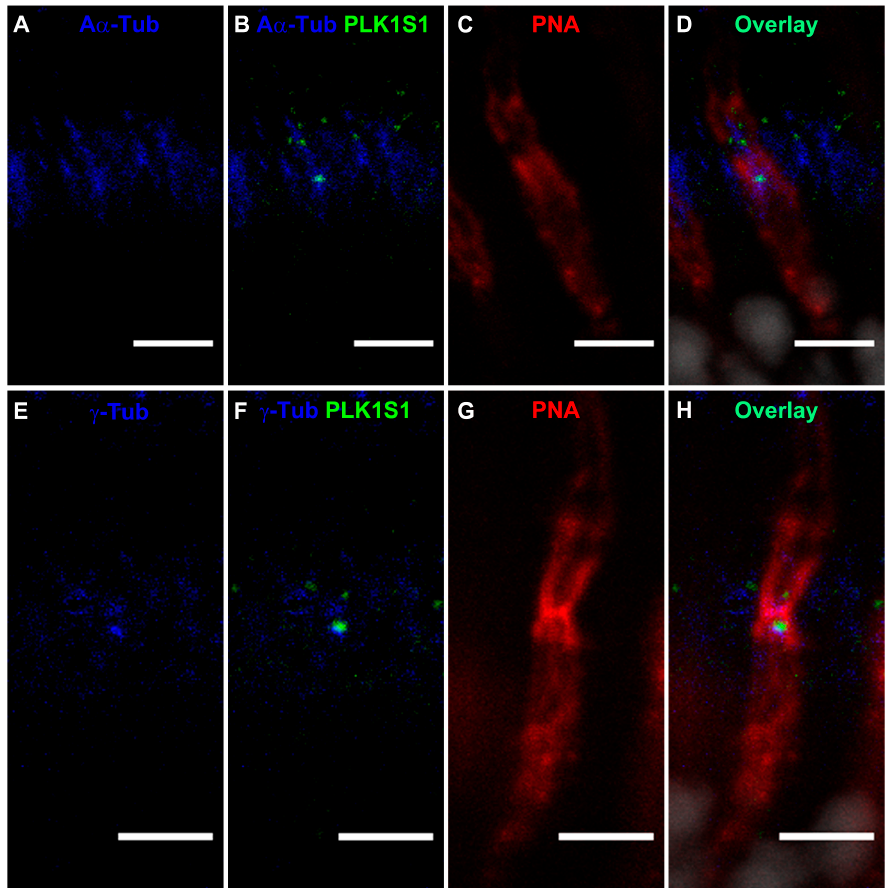
Figure 8. Immunolocalization of PLK1S1 in adult mouse retina revealed PLK1S1 localization in the BB of cone photoreceptors. ( A – H ) Close ‐ up of cilia (acetylated α‐ tubulin (A α‐ Tub) or γ‐ tubulin ( γ‐ Tub), blue) of the cone photoreceptor (PNA, red). Merged images show that PLK1S1 is localized in close vicinity of acetylated α‐ tubulin and γ‐ tubulin most likely in the basal body of cone photoreceptors. Nuclei are stained in DAPI (gray). Scale bar represents 5 μ m.